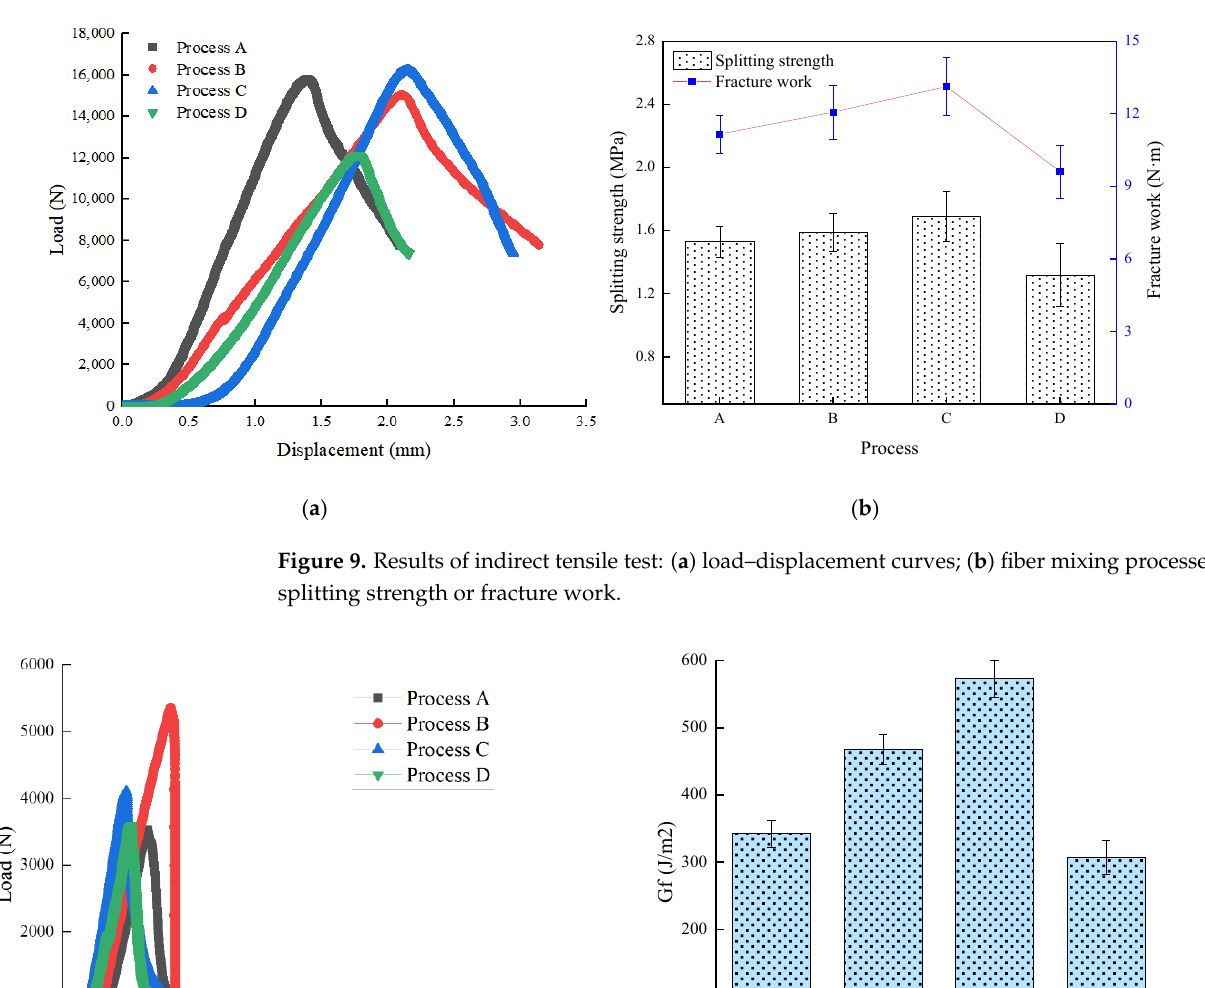
Figure 11. The correlation between fracture energy and fracture work. 4.2. Resistance to Freeze–Thaw Damage Given that there was a good correlation of the results between SCB tests and ID tests, only the ID test was carried out to study the influence of fiber mixing process on the